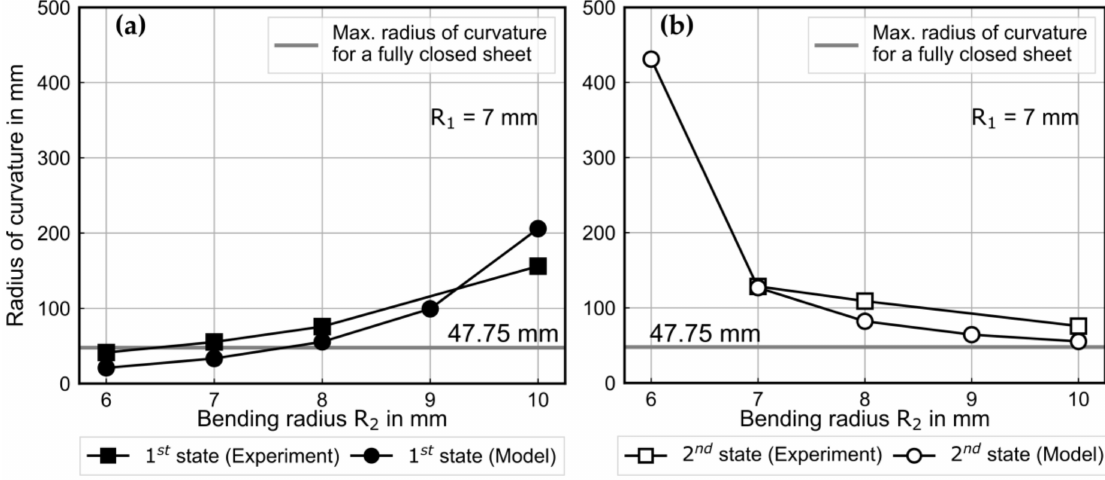
Figure 13. Radii of curvature for first ( a ) and second ( b ) stable state after first bending operation with a radius R 1 = 7 mm and various second bending radii R 2